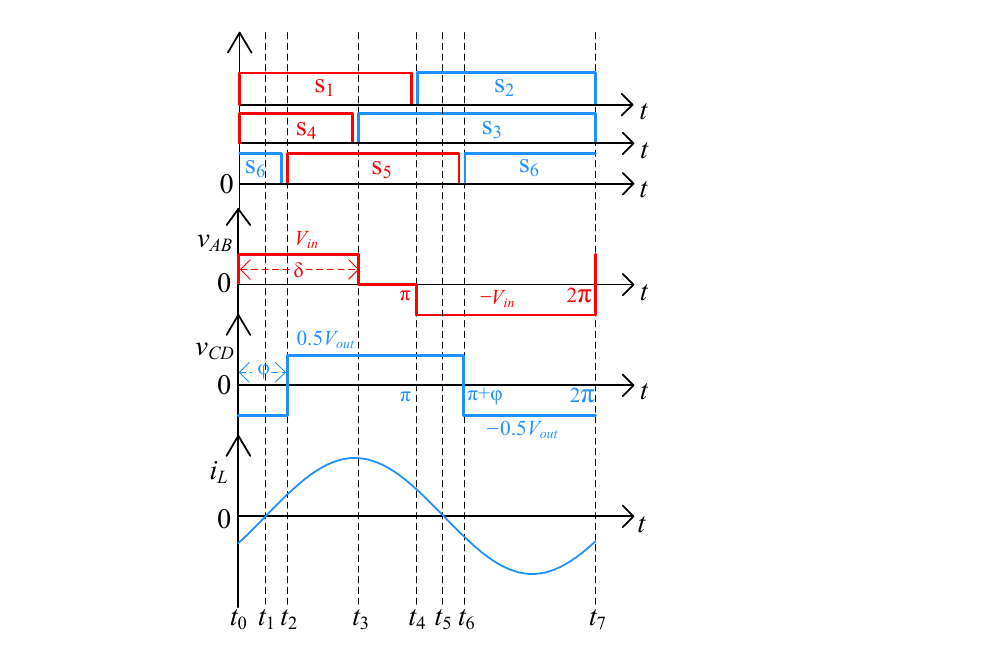
Figure 2. The steady-state waveforms of H-DBRC in forward mode.